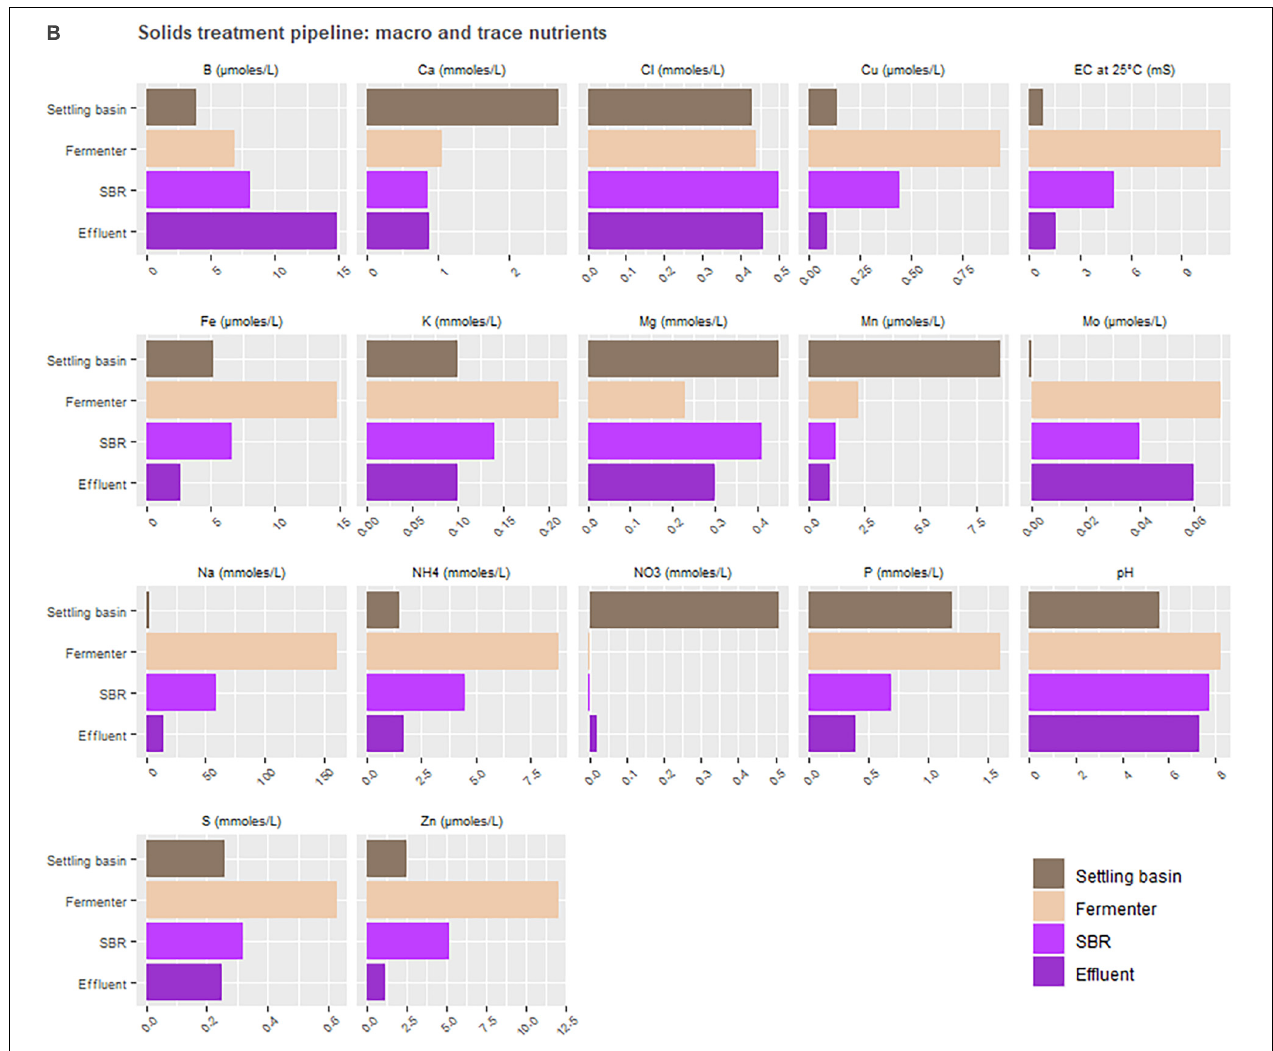
FIGURE 4 | Nutrient load in the recirculating aquaculture system (RAS) (A) and solids treatment pipeline (B) at steady state